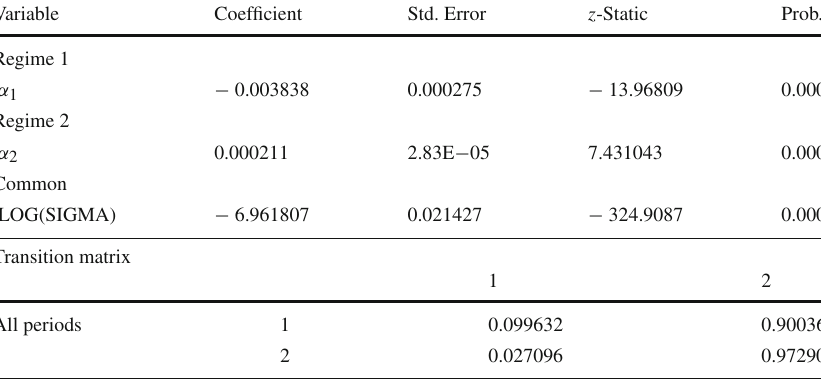
Table 3 The Markov-switching